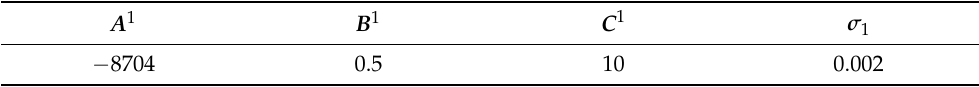
Table 15. Specific values of model parameters.